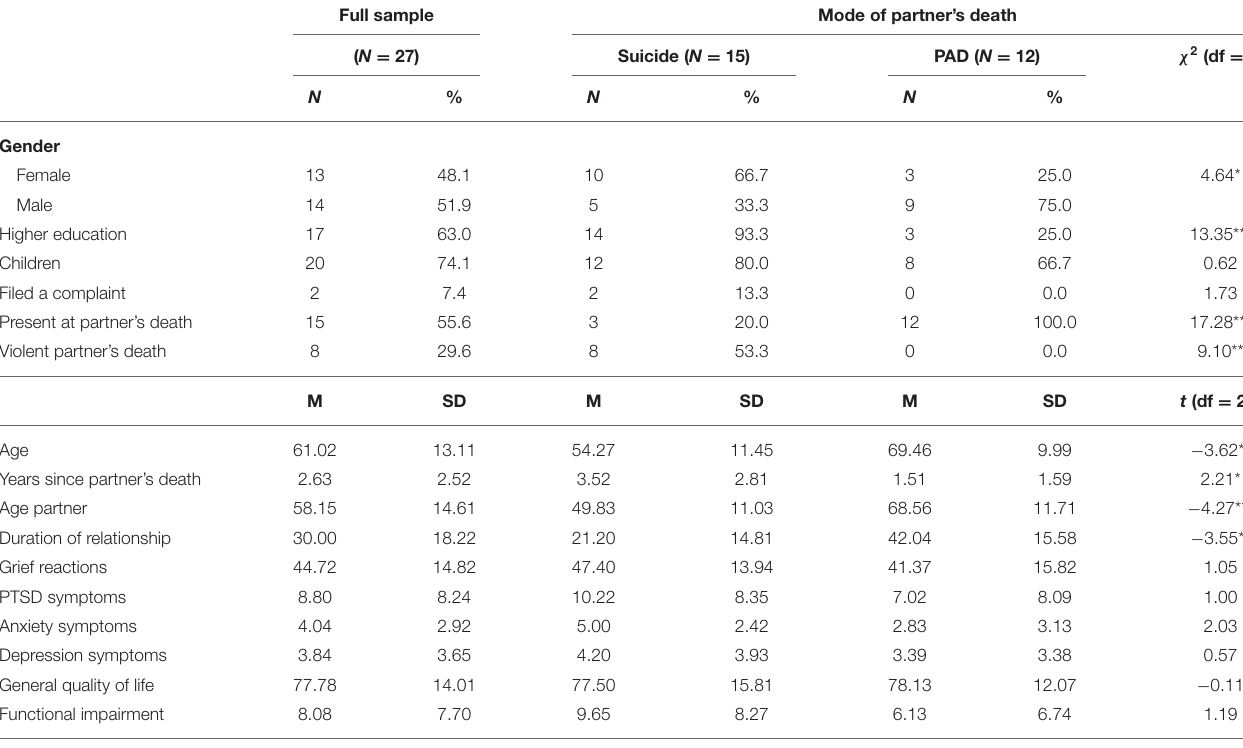
TABLE 2 | Sociodemographic variables and mental health outcomes by mode of partner’s death.